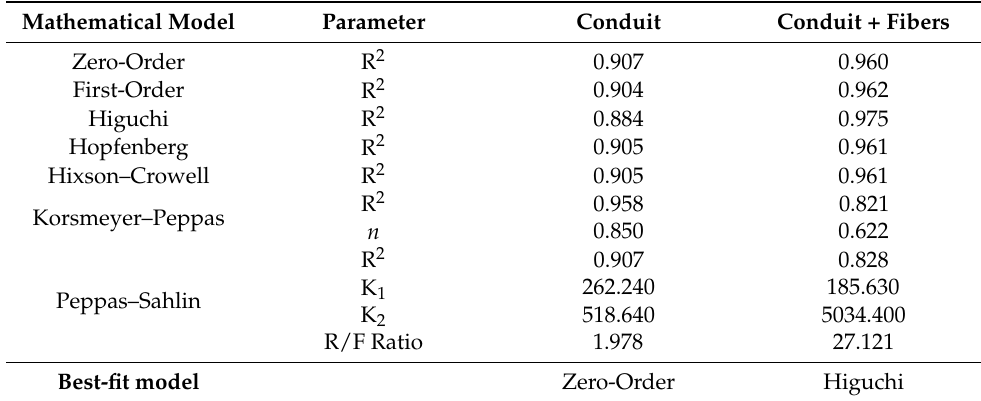
Figure 2. In vitro Nerve Growth Factor (NGF) release profiles from the hollow and fiber-containing conduits over 28 days in PBS pH 7.4 at 37 ◦ C ( n = 3). Table 1. Kinetic data of NGF